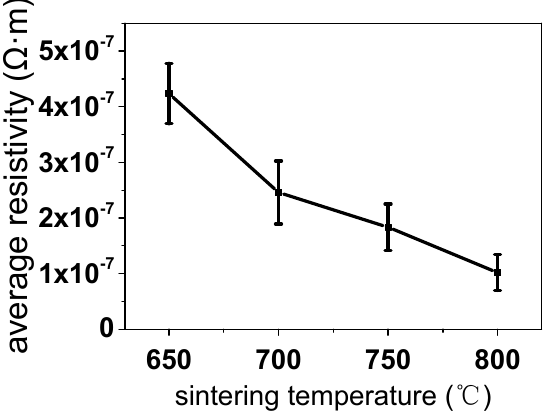
Figure 9. Resistivities obtained by sintering at di ff erent temperatures (600–800 ◦